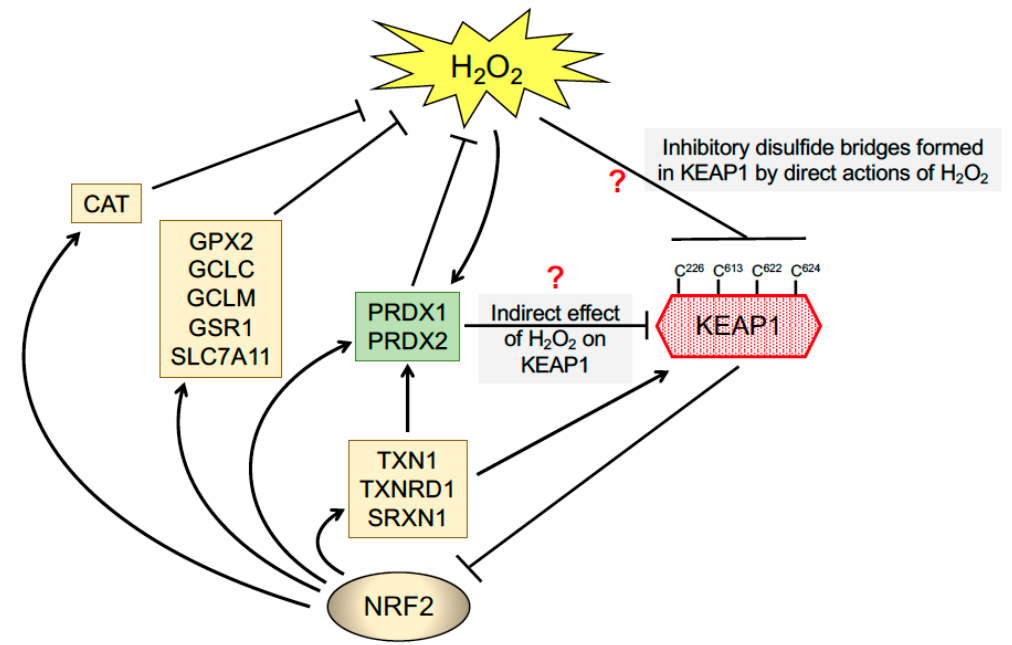
Figure 4. Stimulation of the NRF2-KEAP1 axis by H 2 O 2. The cartoon depicts potential ways in which KEAP1 is inactivated by H 2 O 2 and how induction of NRF2-target genes suppresses intracellular H 2 O 2 levels. In particular, it draws attention to the possibility that PRDX1 and PRDX2 might be the primary sensor of H 2 O 2 and when oxidised, relay this information to KEAP1 by stimulating disulfide bridge formation between Cys226, Cys613, Cys622 and Cys624 in the ubiquitin ligase substrate adaptor, allowing NRF2 to evade ubiquitylation by CRL KEAP1 and induce antioxidant genes (shown in boxes), which in turn serve to supress intracellular H 2 O 2 levels. However, through induction of the TXN-based antioxidant system, activated NRF2 would also stimulate reduction of disulfide bonds in KEAP1, and so restore repression of NRF2 by CRL KEAP1 , thereby providing a negative feedback loop.